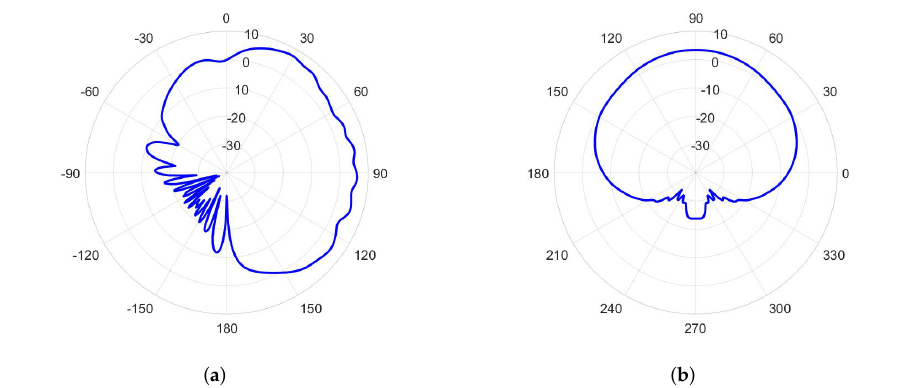
Figure 14. Radiation pattern of the waveguide with single transverse slot placed horizontally on the human phantom with a circular cross-section (smart belt application, Figure 13): ( a ) yz -plane pattern (H-plane), ( b ) xy -plane pattern (E-plane). Radial scale is in dB, angular is in